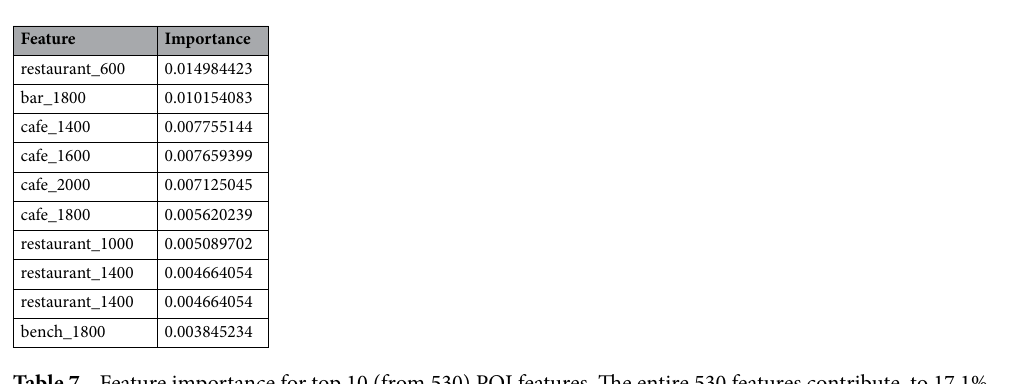
Table 7. Feature importance for top 10 (from 530) POI features. The entire 530 features contribute to 17.1% of the total feature importance.